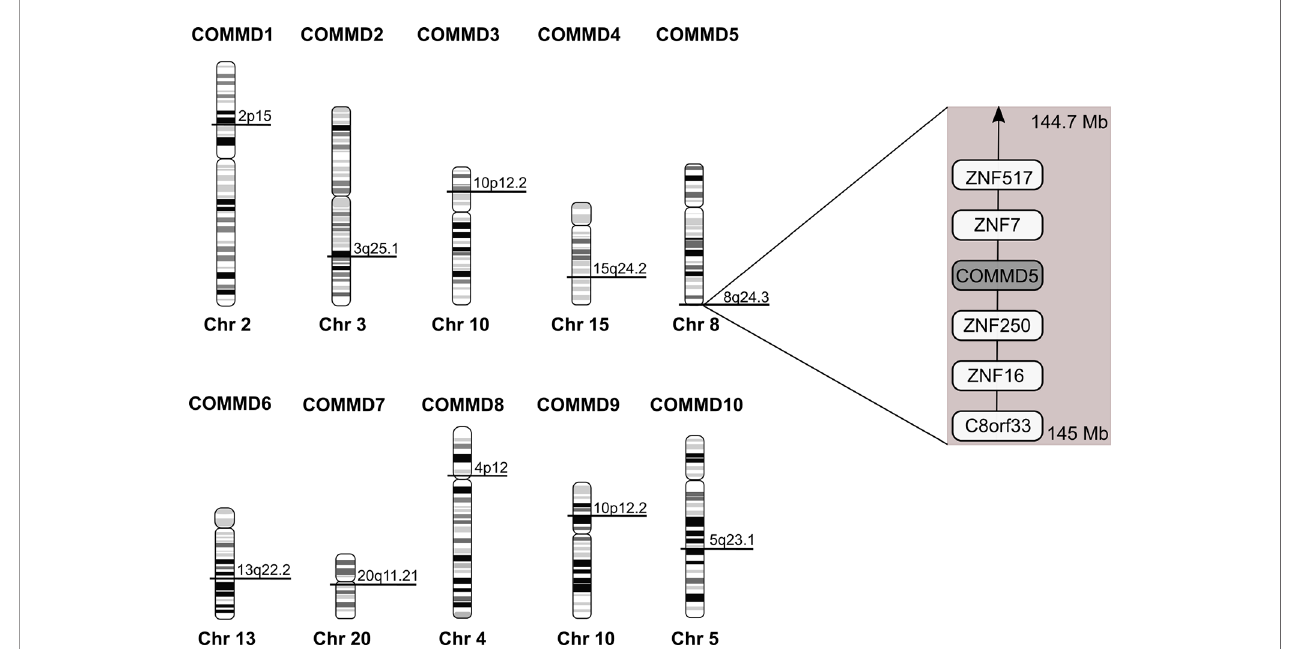
FIGURE 3 | Chromosomal location of the human COMMD family members. Location of COMMD genes was deduced from the homo sapiens genome view of the National Center for Biotechnology Information (Gene ID: 150684 for COMMD1 ; 51122 for COMMD2 ; 23412 for COMMD3 ; 54939 for COMMD4 ; 28991 for COMMD5 ; 170622 for COMMD6 ; 149951 for COMMD7 ; 54951 for COMMD8 ; 29099 for COMMD9 and 51397 for COMMD10 ). COMMD5 is the only COMMD family member located at the extreme end of chromosome. According to The Human Protein Atlas database , COMMD5 is the fourth protein-coding gene from the end of 8q24.3